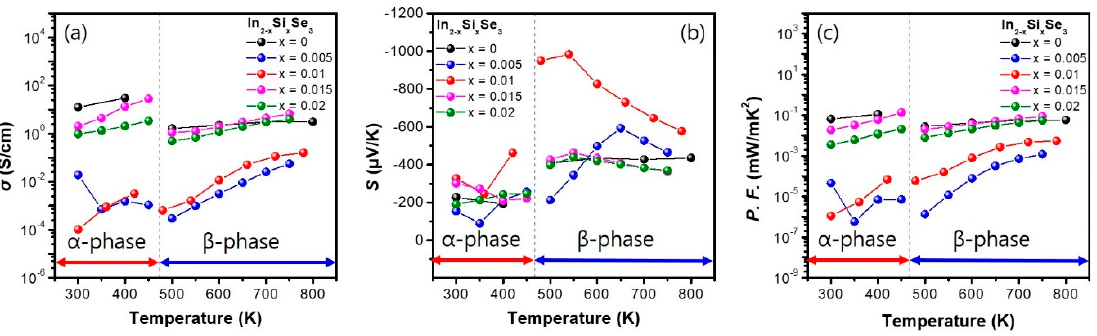
Figure 2. ( a ) Electrical conductivities, ( b ) Seebeck coefficients and ( c ) power factors as a function of temperature for the In 2 − x Si x Se 3 ( x = 0, 0.005, 0.01, 0.015, and 0.02) samples.